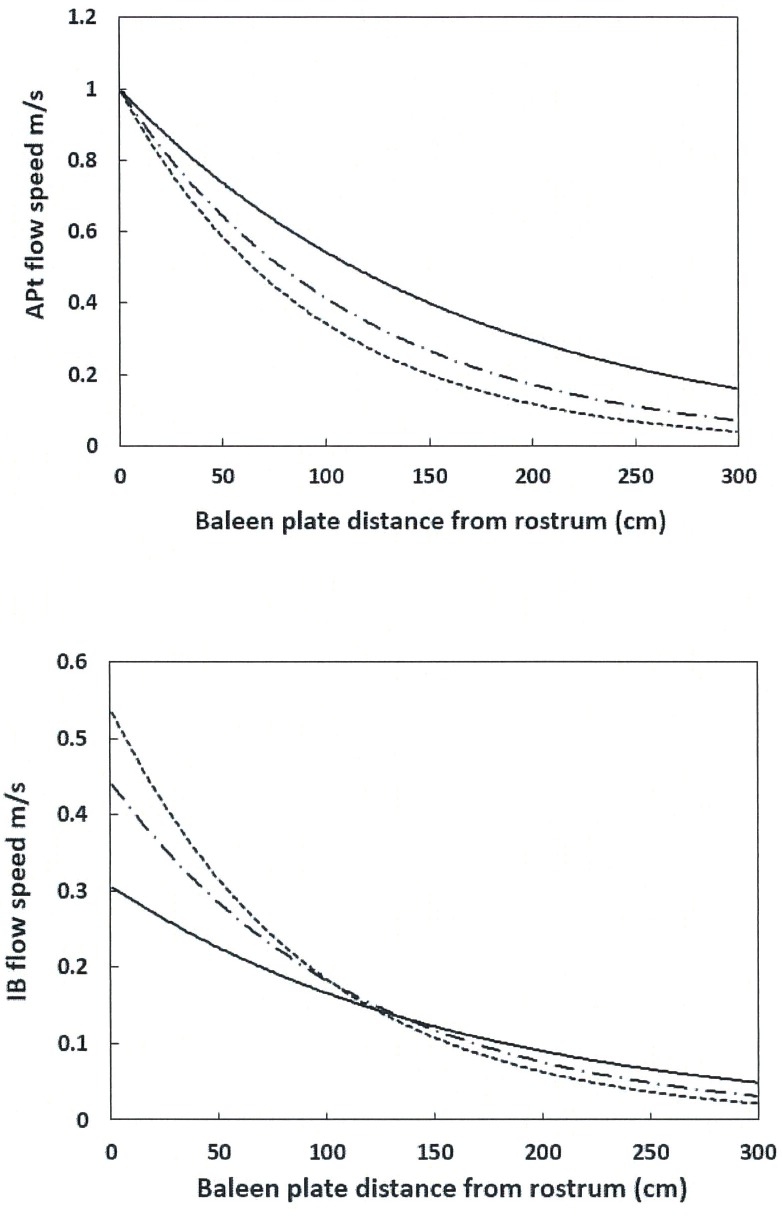
IB and APT flow speeds versus flow-splitting coefficient C.The larger the value of the coefficient, the larger the baleen obstruction by trapped prey. Shown are C = 0.30 (continuous curve), C = 0.44 (dash-dot; “with prey” [9]) and C = 0.53 (dotted; “no prey” [9]). All three cases involve the same mouth inlet flow rate. The rest of the inputs used in both frames where: 10m body length, Uwhale = 1.0m/s, dbaleen = 0.01m, cbaleen = 0.07m, hHT = 1.5m and Din = 0.5m. Further details are listed in Tables 1 and 2.